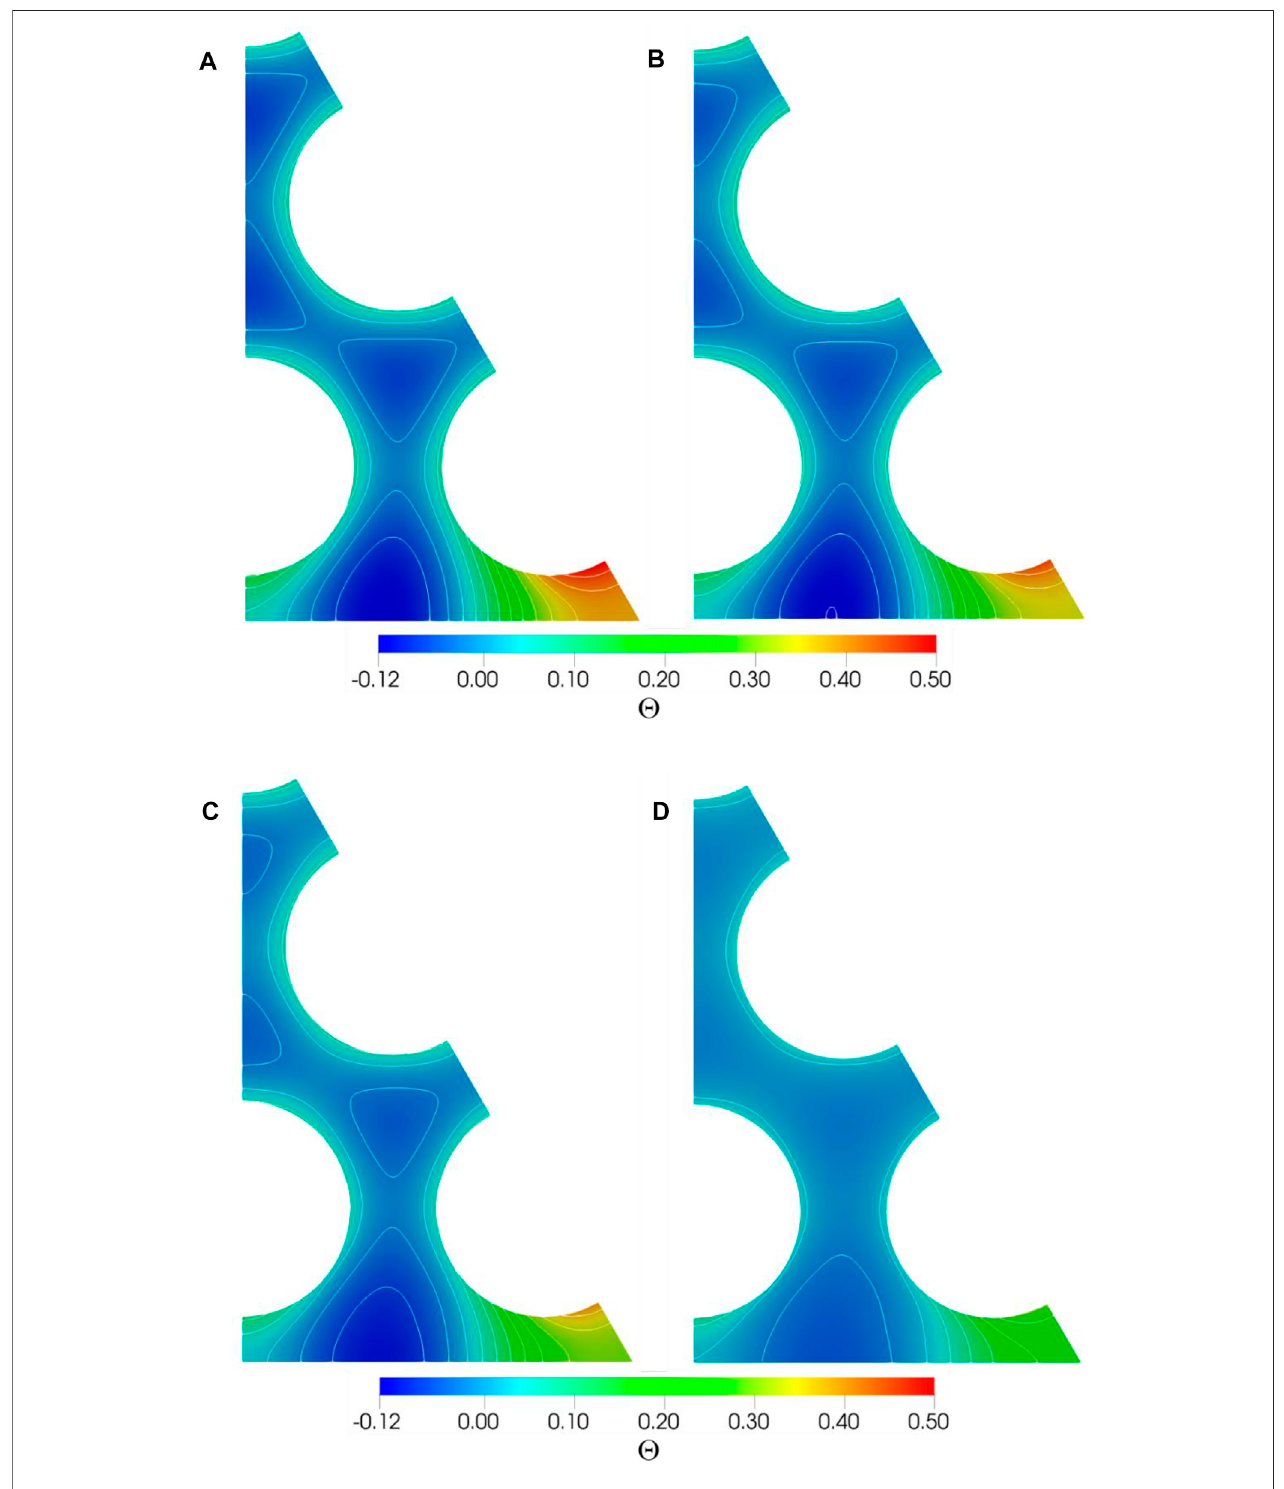
FIGURE 7 | Pro fi les of dimensionless temperature on computational domain. (A) Pe bun (cid:2) 250; (B) Pe bun (cid:2) 500; (C) Pe bun (cid:2) 1000; and (D) Pe bun (cid:2) 3000 .